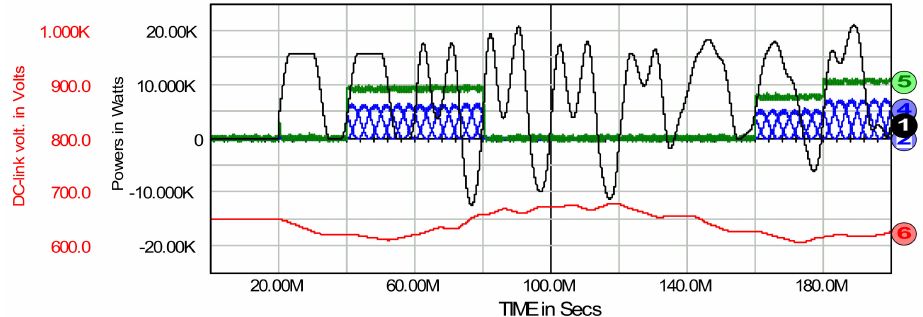
Figure 12. Total instantaneous load power: waveform 1 (in black); source phase powers: waveforms 2, 3, and 4 (all in blue); total source power: waveform 5; DC-link capacitor voltage: waveform